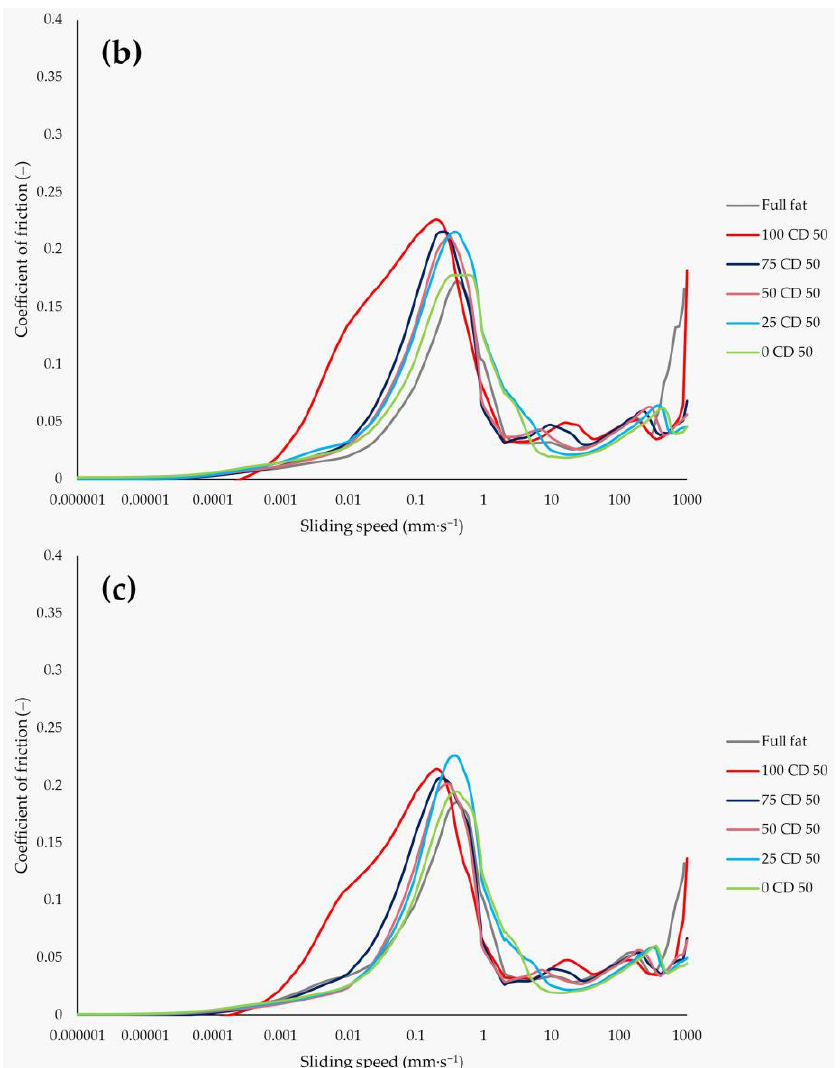
Figure 8. Stribeck curve 1 ( a ), curve 2 ( b ), and curve 3 ( c ): coefficient of friction versus sliding speed of PCS samples with different CD concentrations. The curves are mean values of all four measurements per each batch.